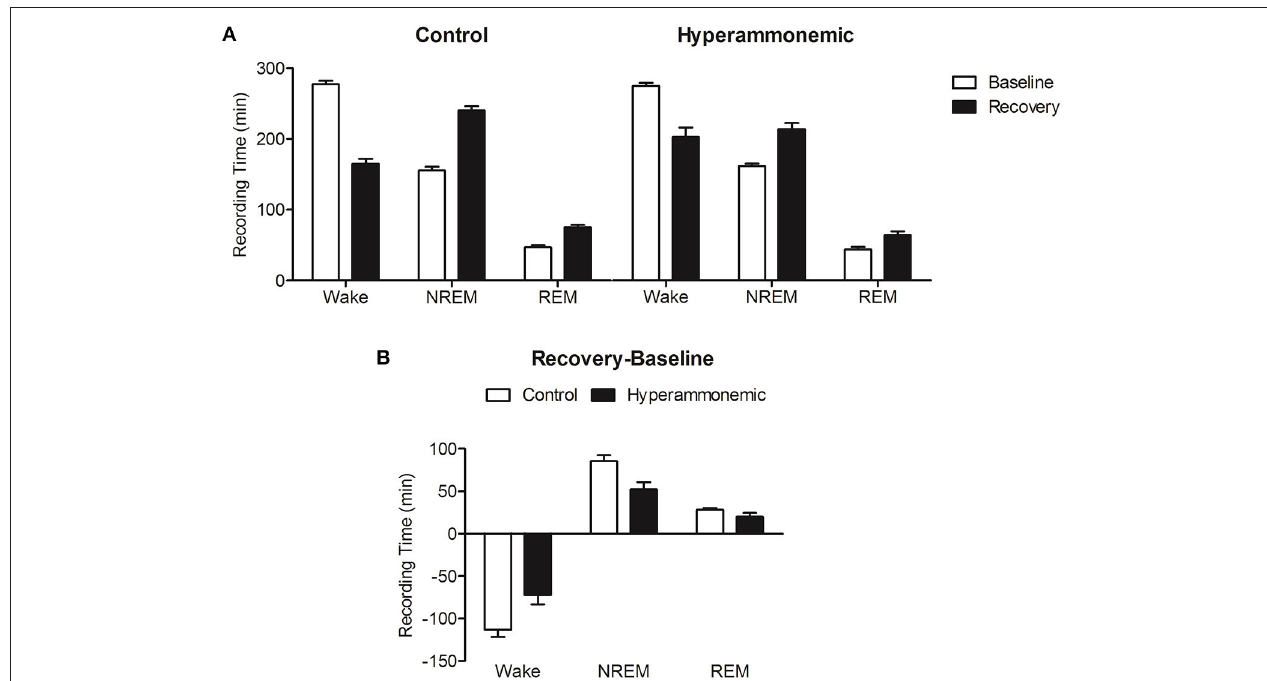
FIGURE 5 | (A) Decrease in Wakefulness time (min) and increase in NREM and REM sleep time after sleep deprivation (9–16h, black bars) with respect to baseline (white bars), in control (left) and hyperammonemic (right) animals. (B) Comparison of the differences (recovery minus baseline, 9–16h) in Wakefulness, NREM and REM sleep time (min) between control (white bars) and hyperammonemic (black bars)